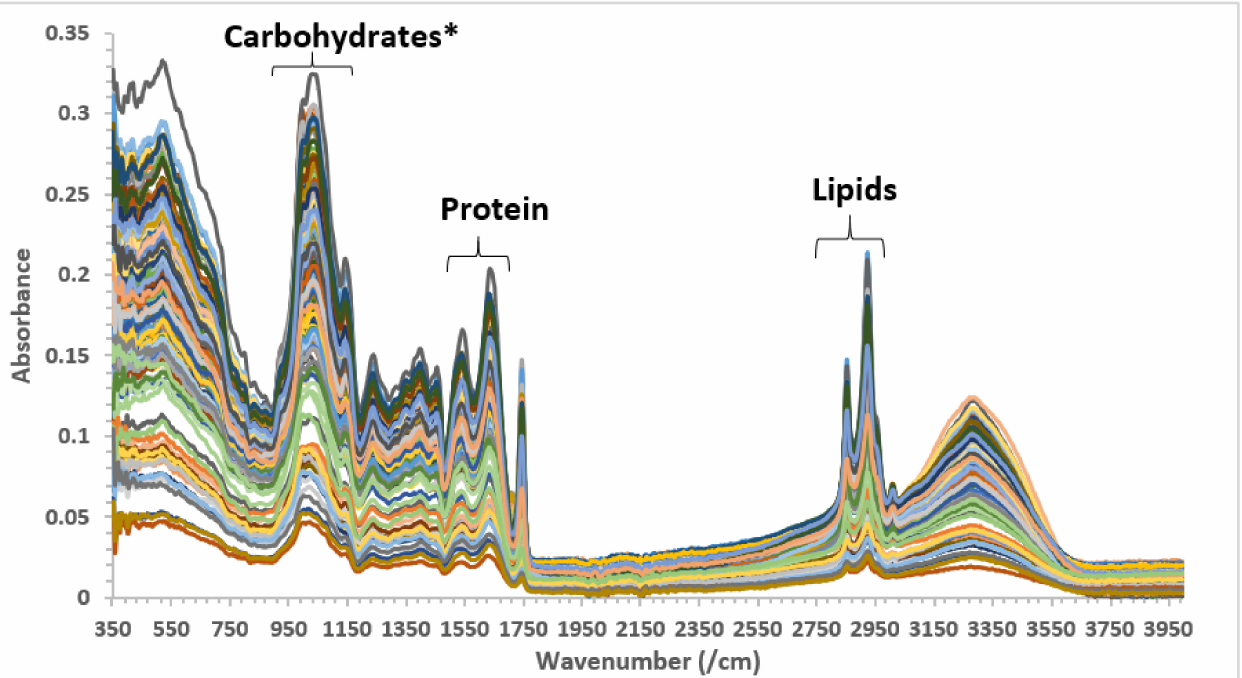
Figure 1. Mid-infrared spectra of raw and roasted acacia seed species collected from different regions in Australia. * Structural and non-structural